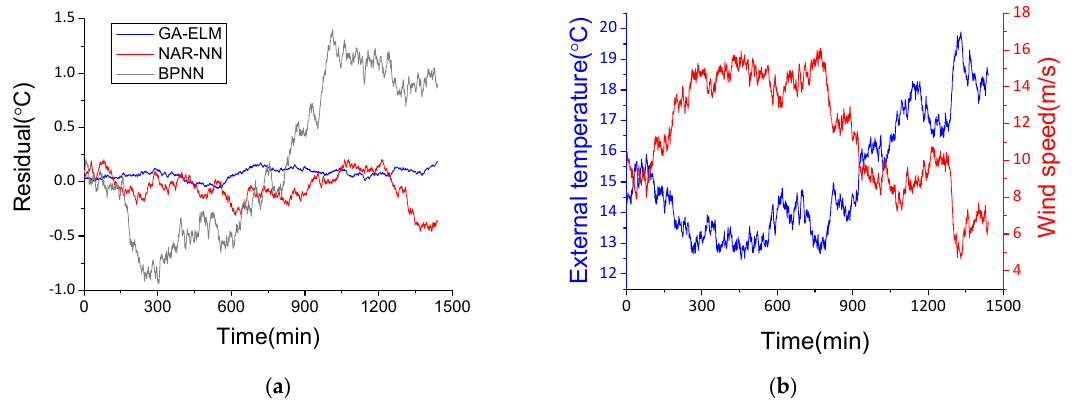
Figure 7. ( a ) Model testing results of different intelligent algorithms; ( b )ambient conditions of testing set.